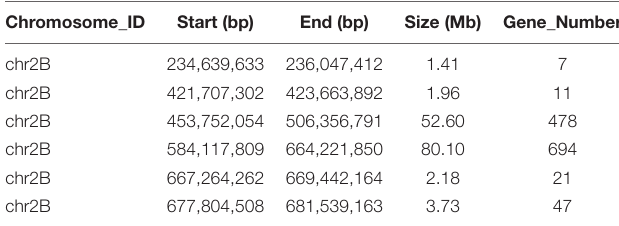
Frontiers in Plant Science |